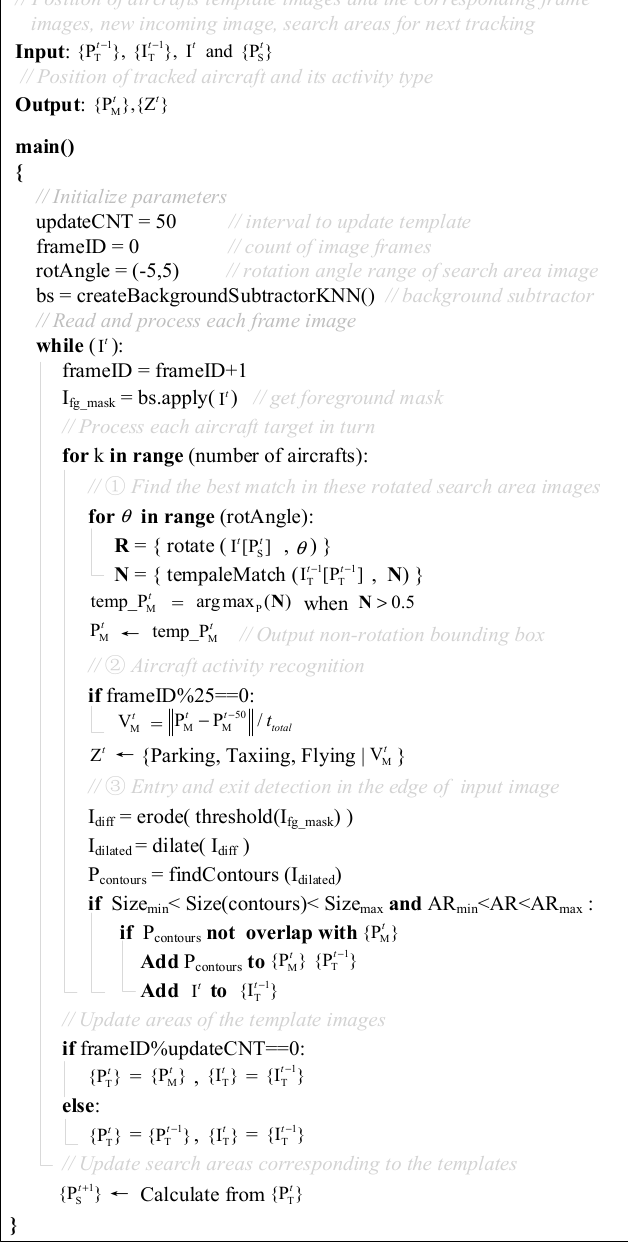
Algorithm 1. Algorithm for aircraft tracking and activity recognition. Figure 7. Algorithm for aircraft tracking and activity